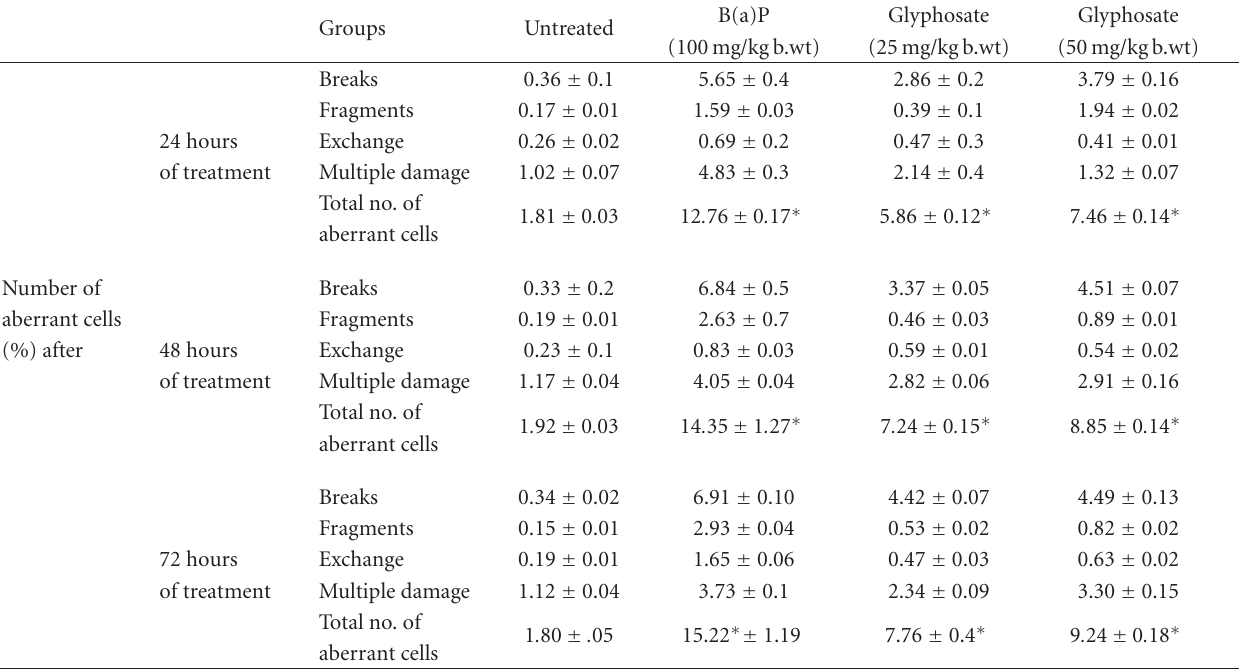
Table 1: E ff ect of glyphosate treatment on induction of chromosomal aberration in swiss albino mice.